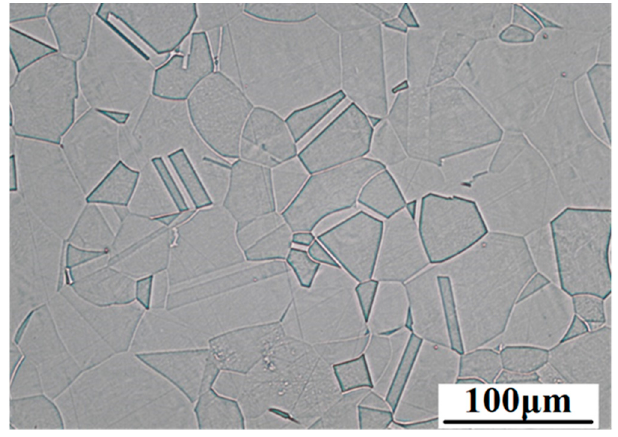
Figure 1. Microstructure of AISI 316L stainless steel, longitudinal section (Kalling’s 2 etch., OM, magnification 500×).